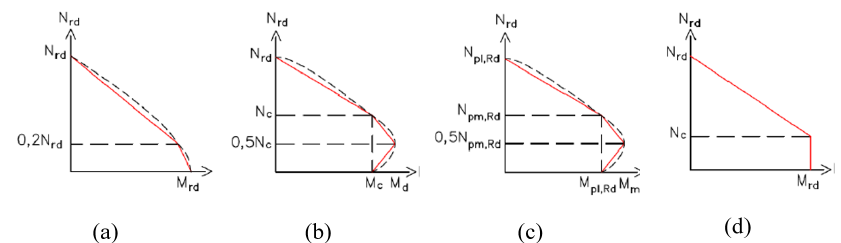
Figure 2 – Interaction diagrams for bending moment vs. axial force – (a) Design model I ABNT NBR 8800 [1]; (b) Design model II ABNT NBR 8800 [1]; (c) ABNT NBR 16239 [2]; (d) EN 1994-1-1